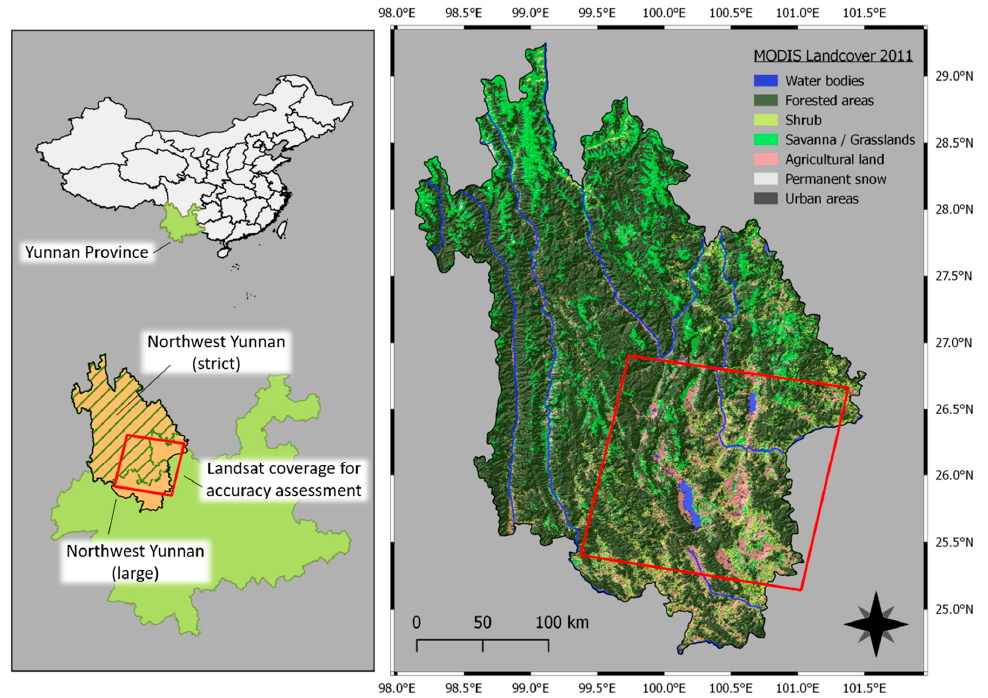
Figure 1. Location of the study area. The most restrictive boundaries of northwest Yunnan and a broader definition of the region, as well as the Landsat coverage selected for the accuracy assessment are represented. The large map shows the main landcover classes according to MODIS MCD12Q1 product for 2011 over a shaded relief. The four major rivers flowing across the region in a parallel manner on the northern section, from West to East: the Dulongjiang (tributary of the Irrawaddy), the Nujiang (upper Salween), the Lancangjiang (upper Mekong), and the Jinshajiang (upper Yangtze). (MCD12Q1 reference: (https://lpdaac.usgs.gov/dataset_discovery/modis/modis_products_table/mcd12q1,